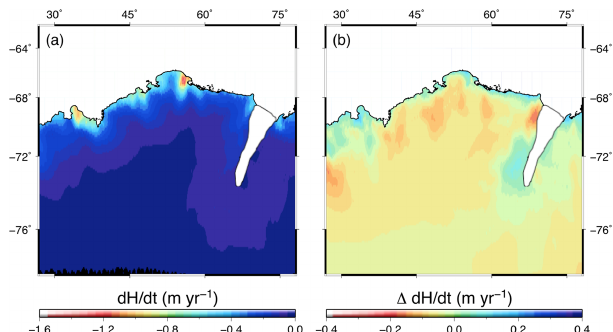
Figure 2. (a) Average annual vertical velocity rates due to firn com- paction across the study site as obtained from our monthly firn com- paction model, and (b) the differences between our model results and the firn densification model of Ligtenberg et al.